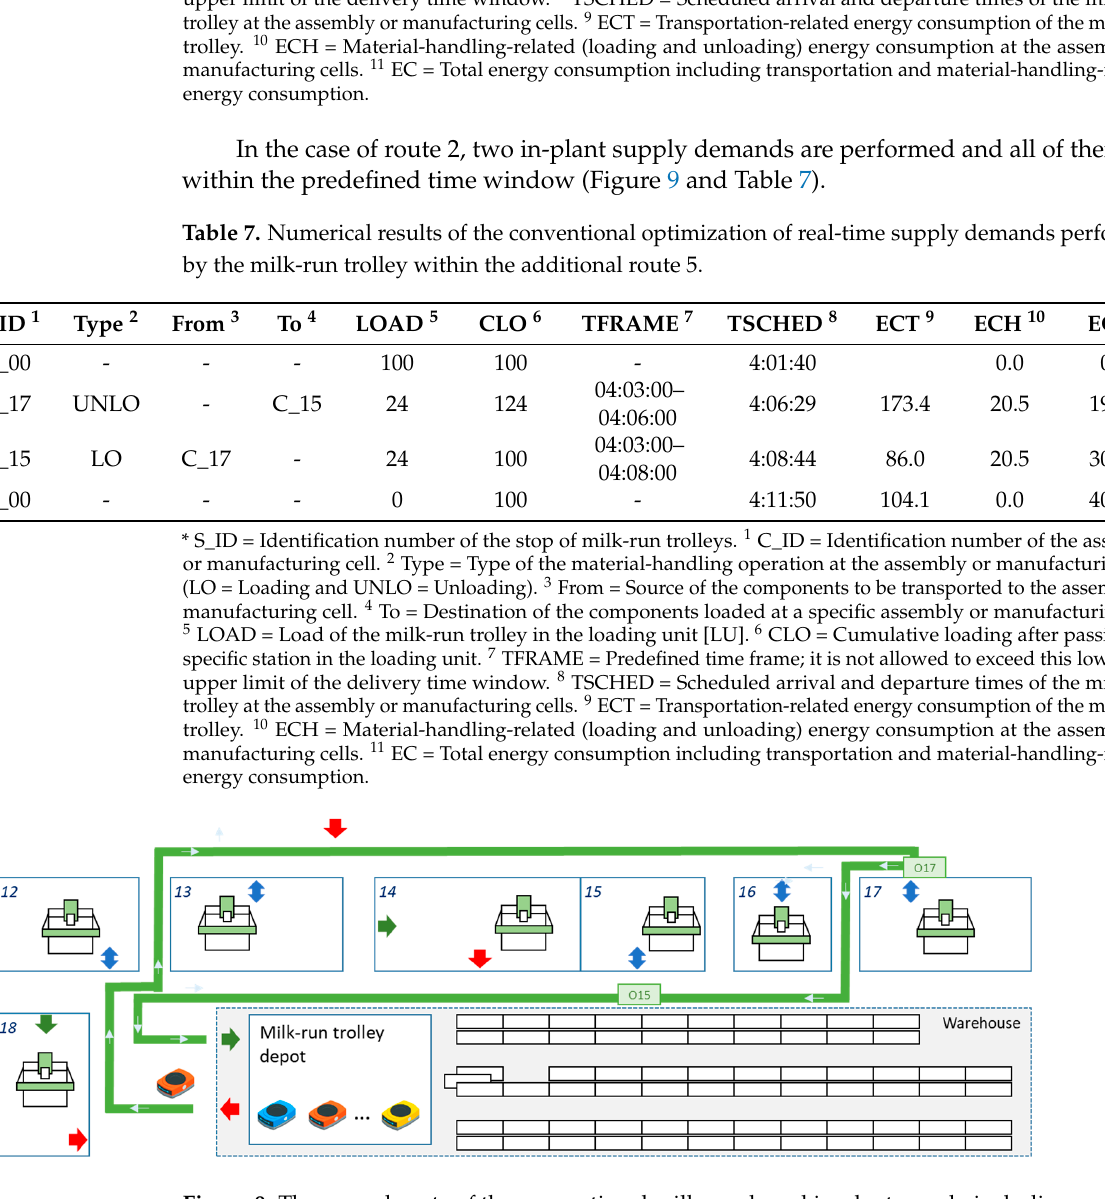
Table 6. Numerical results of the conventional optimization of real-time supply demands per- formed by the milk-run trolley within the additional route 4.